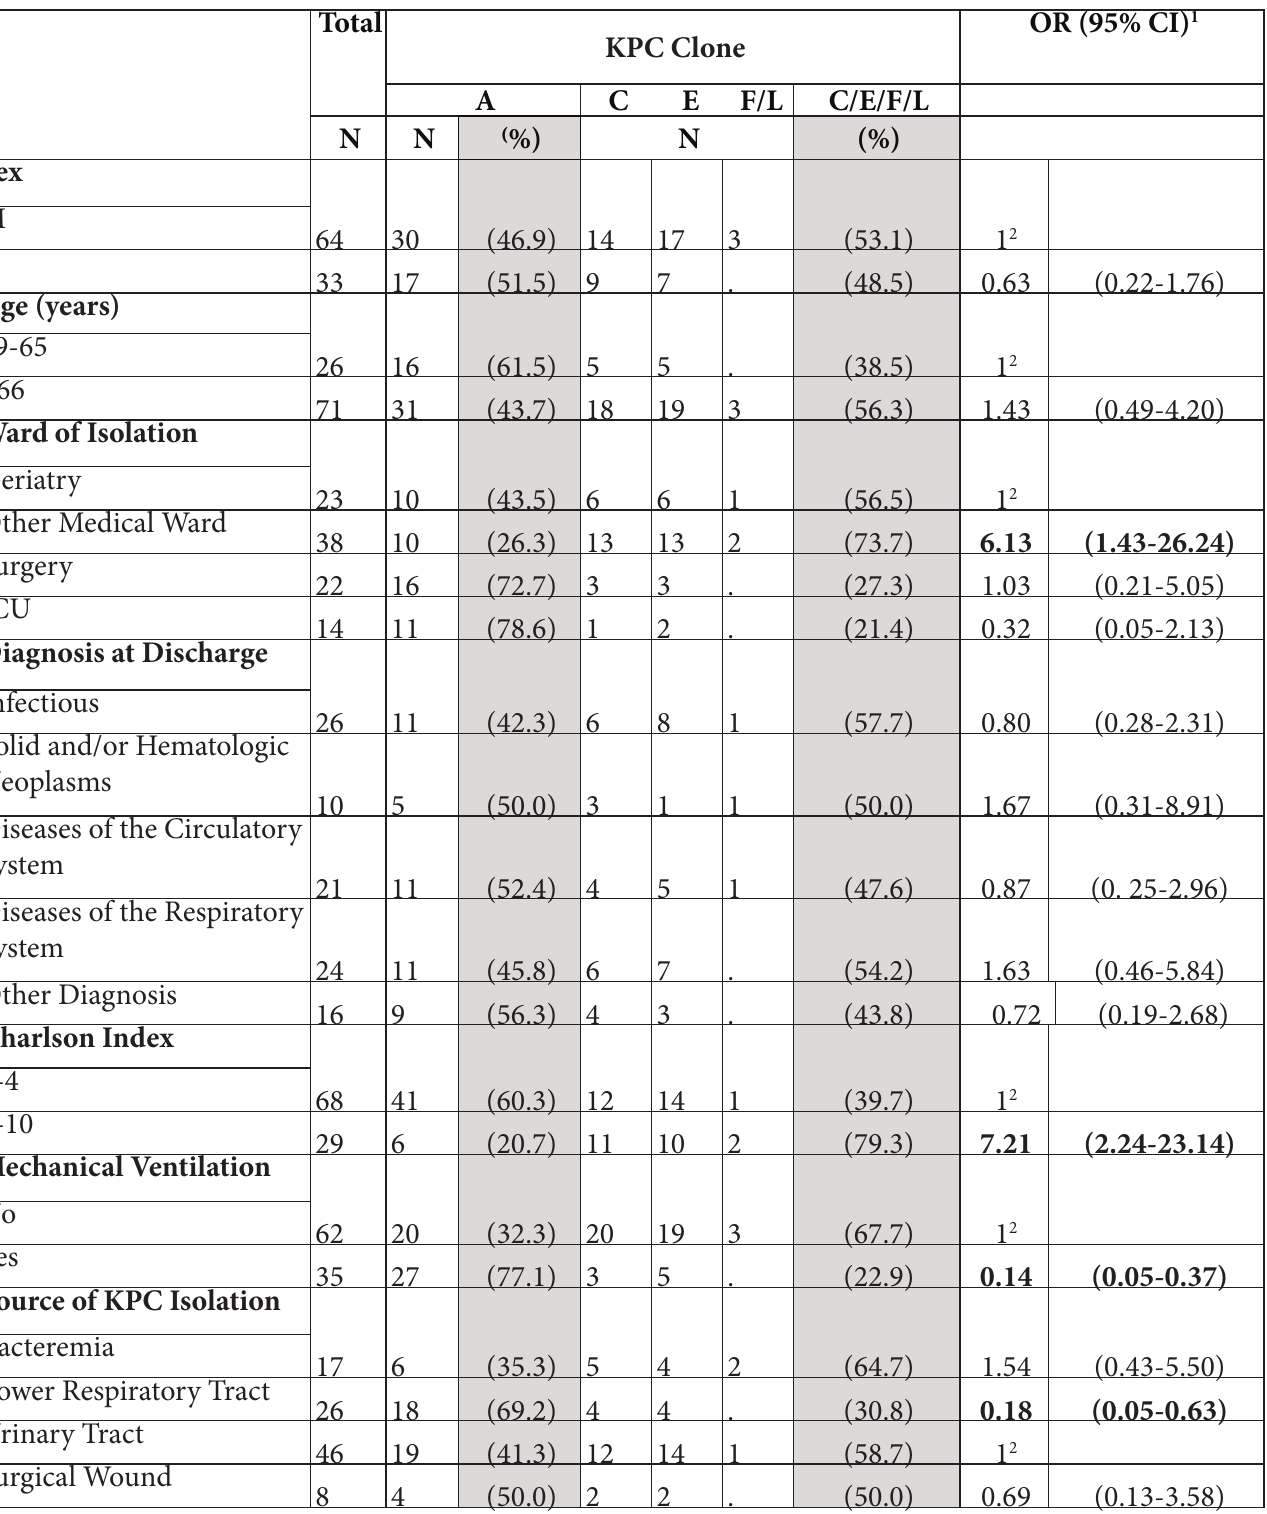
Table 2. Distribution of major patient characteristics in strata of KPC clones with the corresponding odds ratio (OR) of being infected by clones C, E, F, or L compared to clone